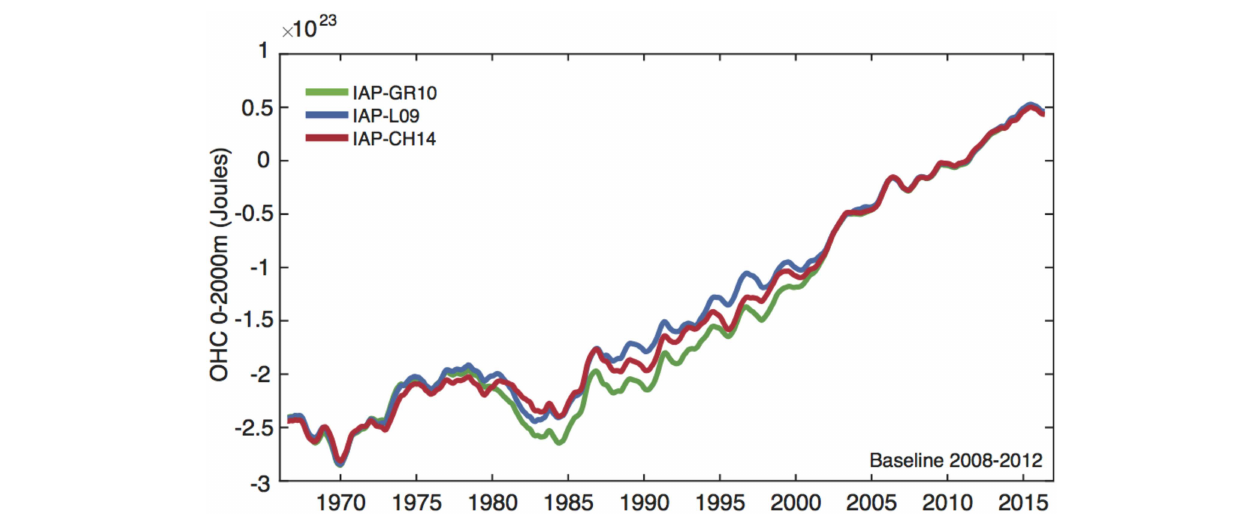
FIGURE 12 | Global OHC time series in the upper 2000m after applying three XBT data improvement schemes: Levitus et al. (2009)-L09 (blue); Gouretski and Reseghetti (2010) -GR10 (green); and Cheng et al. (2014)-CH14 (red) based on the mapping method proposed by the Chinese Institute of Atmospheric Physics (IAP) in Cheng and Zhu